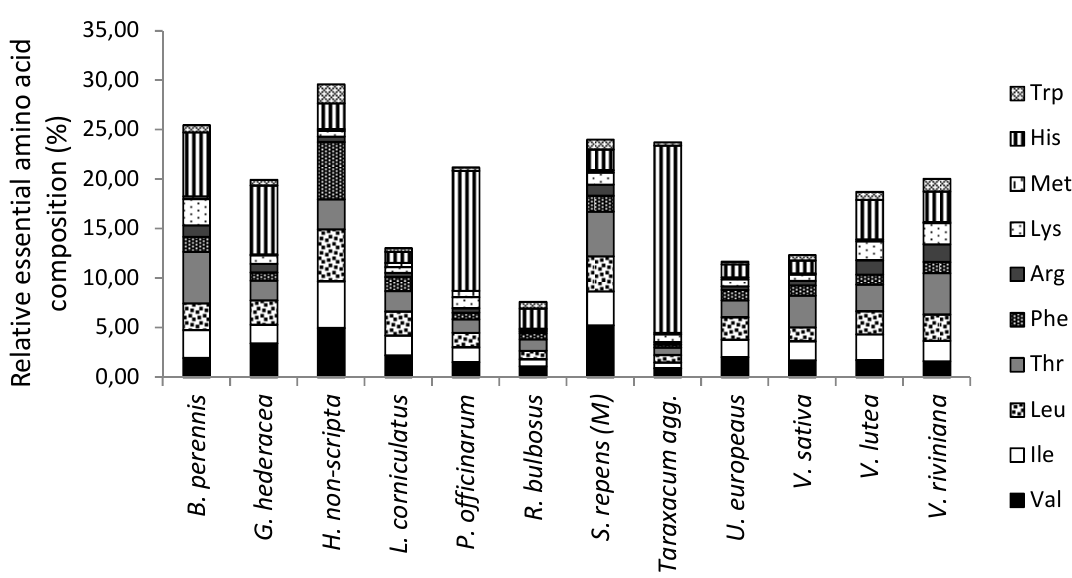
F IGURE 3. Relative essential amino acid composition (%) in pollen for the following species: Bellis perennis , Glechoma hederacea, Hyacinthoides non-scripta, Lotus corniculatus, Pilosella officinarum, Ranunculus bulbosus, Salix repens (Female), Salix repens (Male), Taraxacum agg. , Vicia sativa, Viola lutea, Viola riviniana . Legend abbreviations: Val = Valine, Ile = Isoleucine, Leu = Leucine, Thr = Threonine, Phe =